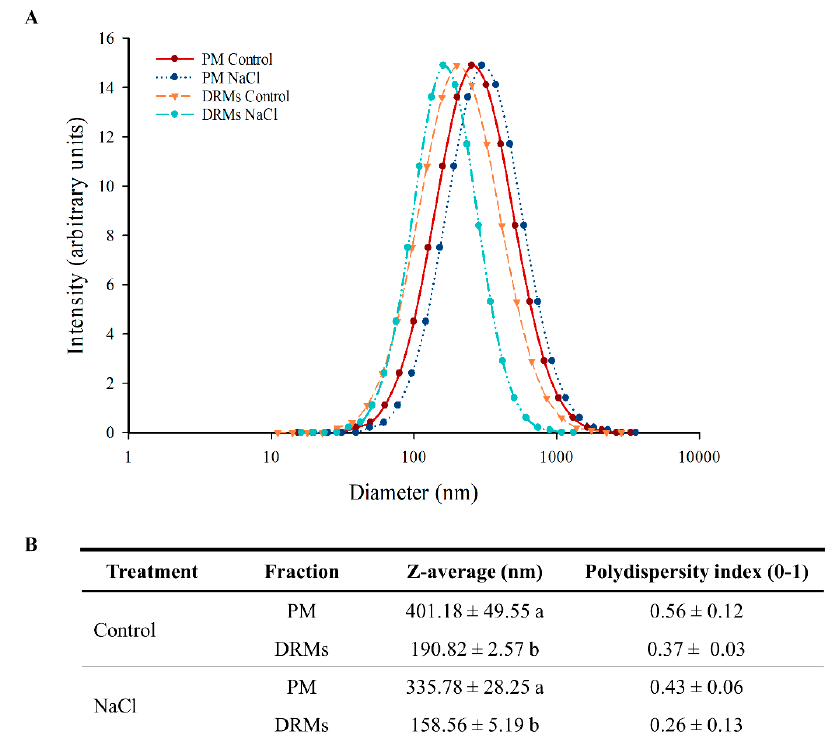
Figure 4. Size distribution ( A ) and average size and polydispersity index ( B ) of plasma membrane (PM) and detergent-resistant membranes (DRMs) from broccoli roots treated with 0 (control) and 80 mM NaCl. Data are means ± SE ( n = 3). Analyses were done with three biological samples. Different letters (a, b) represent significant differences according to t-test for each fraction ( p < 0.05).